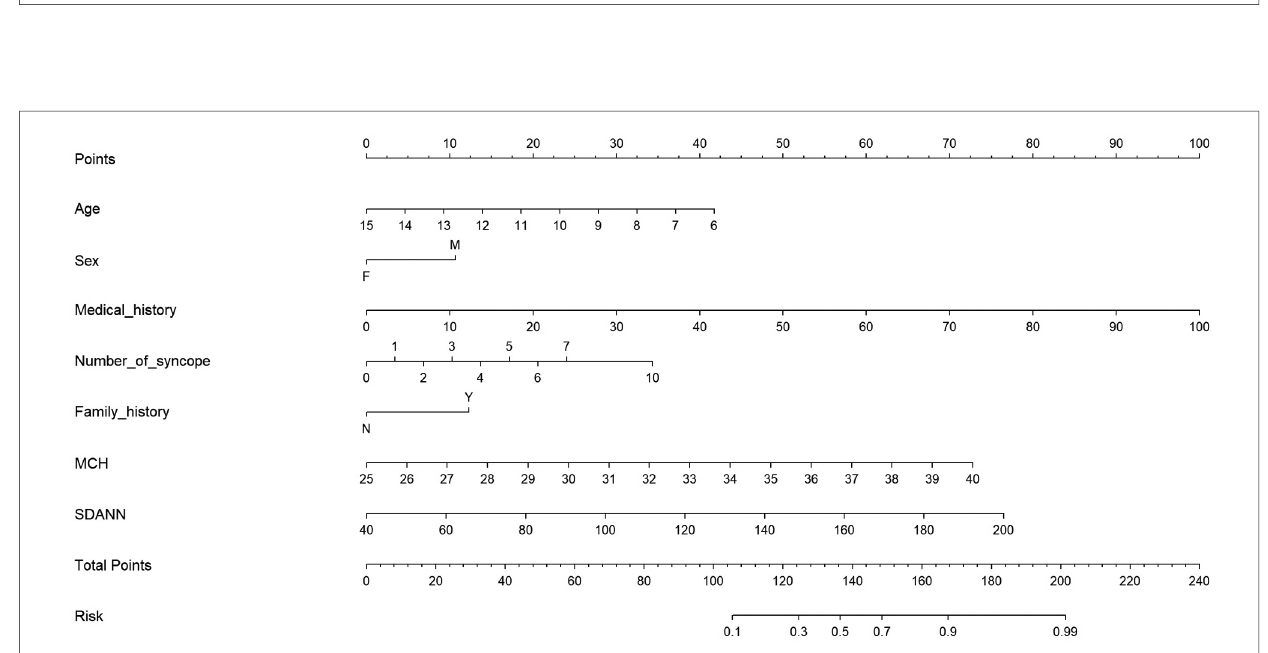
FIGURE 2 ( A ) decision curves analysis for malignant vasovagal syncope. ( B )ROC curves for the two model. The basic model included age, sex, body mass index, medical history, number of syncope and family history. The full model included indicators in basic model and add MCH and SDANN. Abbreviations: MCH, mean corpuscular hemoglobin; SDANN, standard deviation of the average NN intervals.